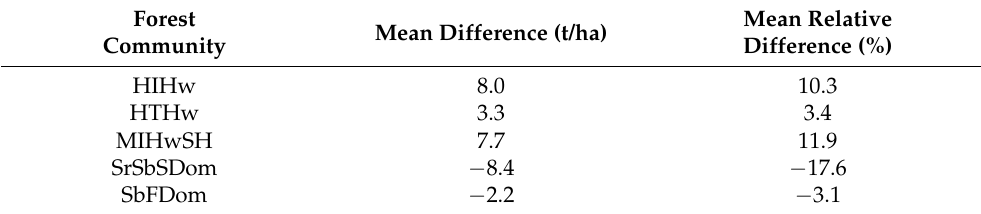
Table 4. Mean differences in carbon estimation at the stand level between CBM and PSP estimation methods (CBM–PSP) for the total stand-level carbon estimation over 150 years.